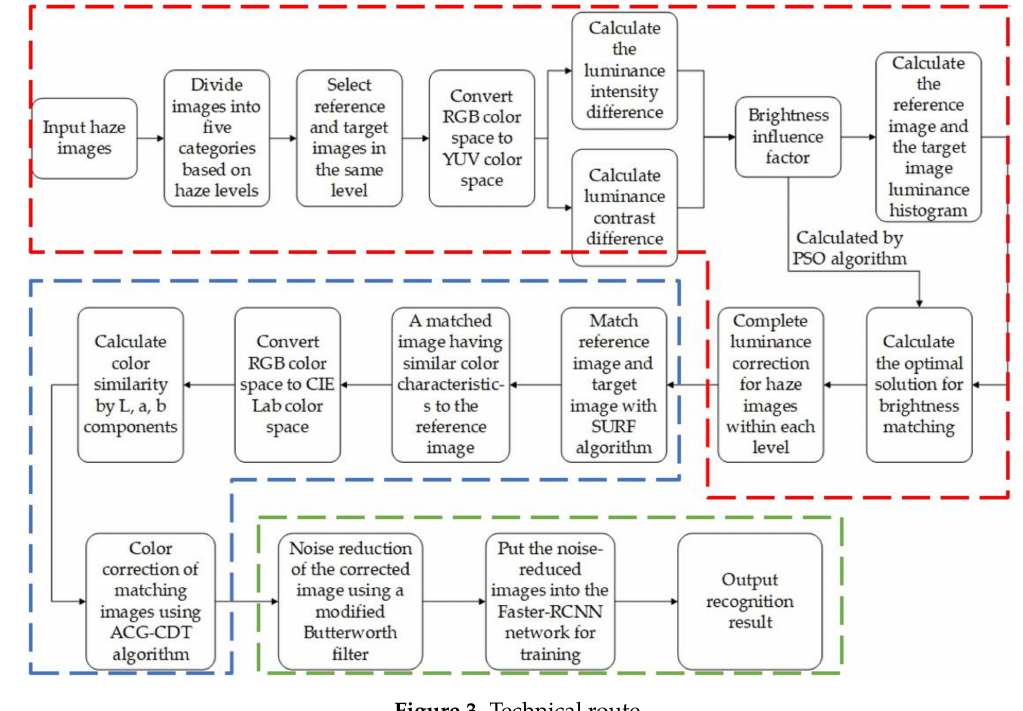
Figure 3. Technical